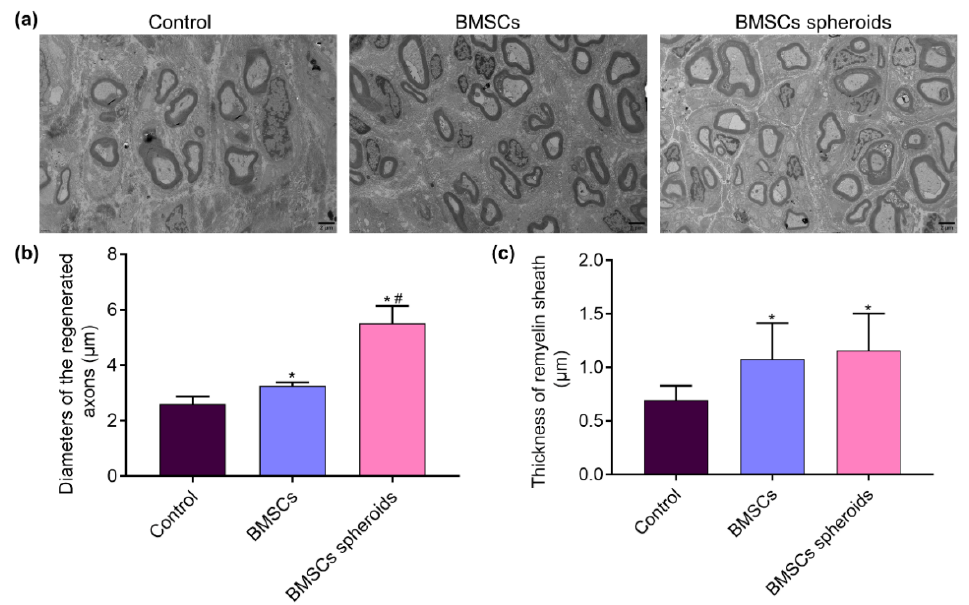
Figure 12. Histological evaluation of the regenerated nerve fibers. ( a ) TEM images of the regenerated sciatic nerve transverse sections 8 weeks postoperatively. ( b ) Diameters of the regenerated nerve fibers. Data are expressed as median with interquartile range ( n = 5 for each group). ( c ) Thickness of remyelination sheath. Data are expressed as mean ± SEM ( n = 5 for each group). * p < 0.05, vs. Control group; # p < 0.05, vs. BMSCs group. Diameters of the regenerated nerve fibers (non-parametric test followed by Kolmogorov–Smirnov and Shapiro–Wilk tests). Thickness of remyelination